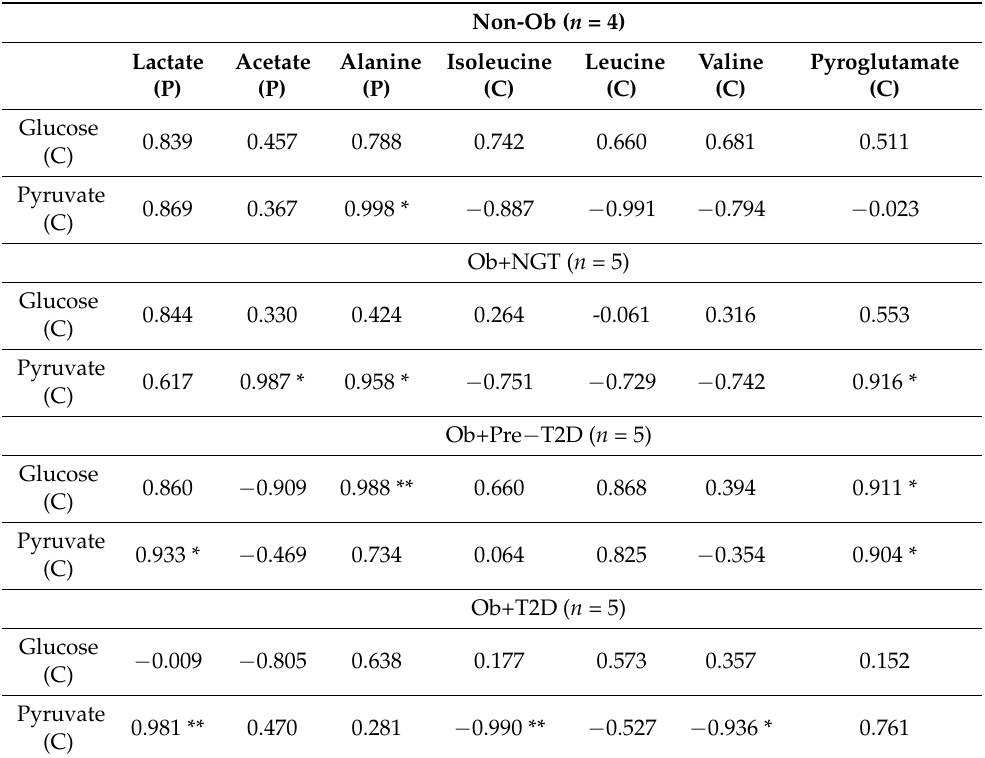
Table 2. Pearson correlation coefficients between glucose and pyruvate consumption and metabo- lite